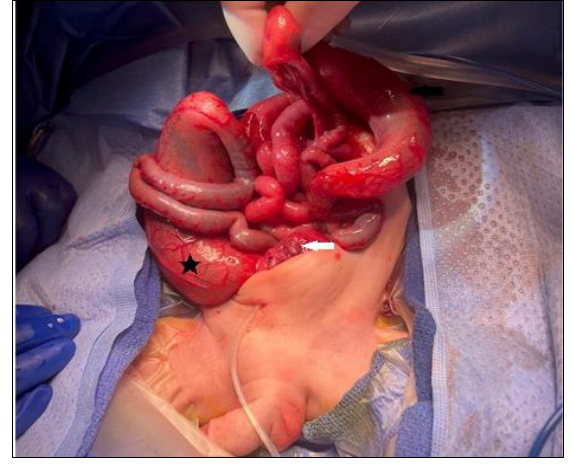
Figure 3: Intraoperative photo showing the dilated cecum and ascending colon (black arrow), with an abrupt change in caliber at the transverse colon. Pouch colon (black asterisk) and urinary bladder (white arrow) are also